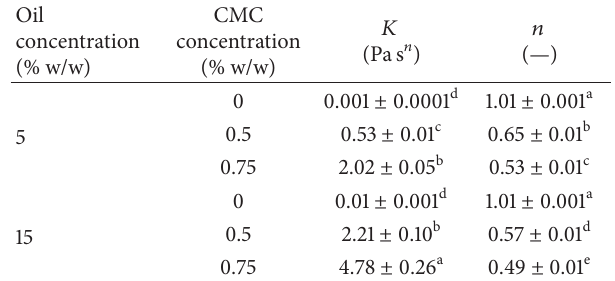
Table 3: Mean values and significant differences of flow param- eters ( 𝐾 : consistency index and 𝑛 : flow behavior index) for O/W nanoemulsions based on olive oil with different CMC concentra-